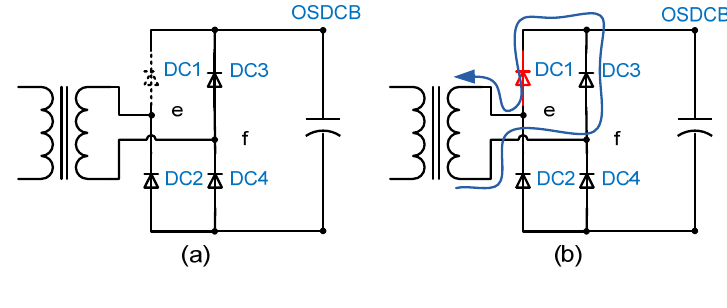
Figure 10. Schematic diagrams of isolation stage for ( a ) Fault E1 (diode DC1 open-circuit) and ( b ) Fault F1 (diode DC1